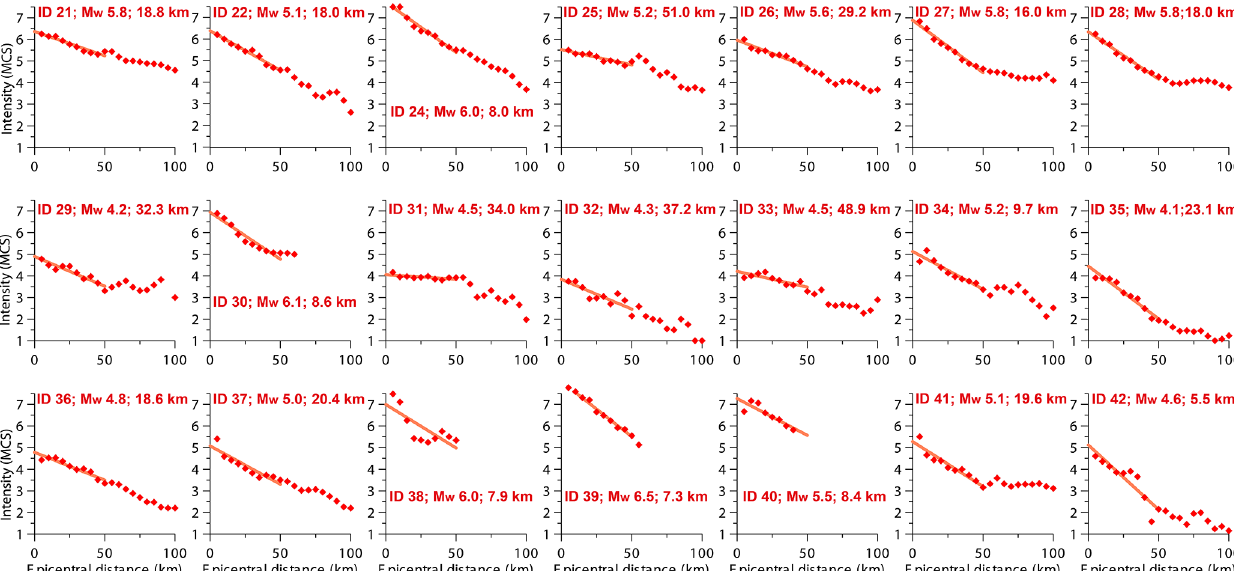
Figure 4. Attenuation curves obtained for the central and southern Italian earthquakes in the learning set (Table 1, from no. 21 to no. 42, except for no. 23; red symbols in Figs. 1 and 5). Individual intensity data points were obtained by averaging the intensity values as shown in Fig. 2. We obtained the linear fit for the first 50km of each curve and calculated the resulting